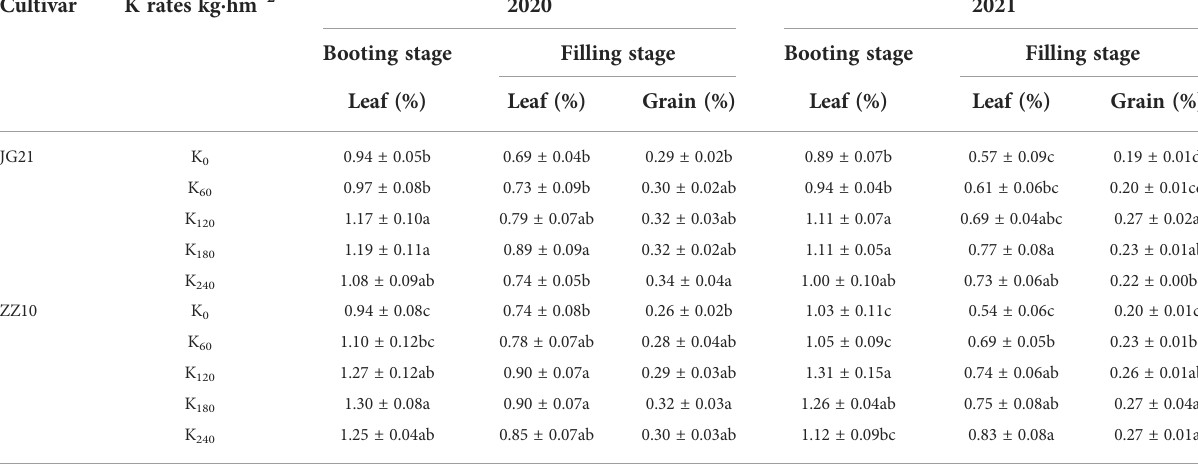
TABLE 1 Effect of potassium application on K content in foxtail millet leaves and grains.